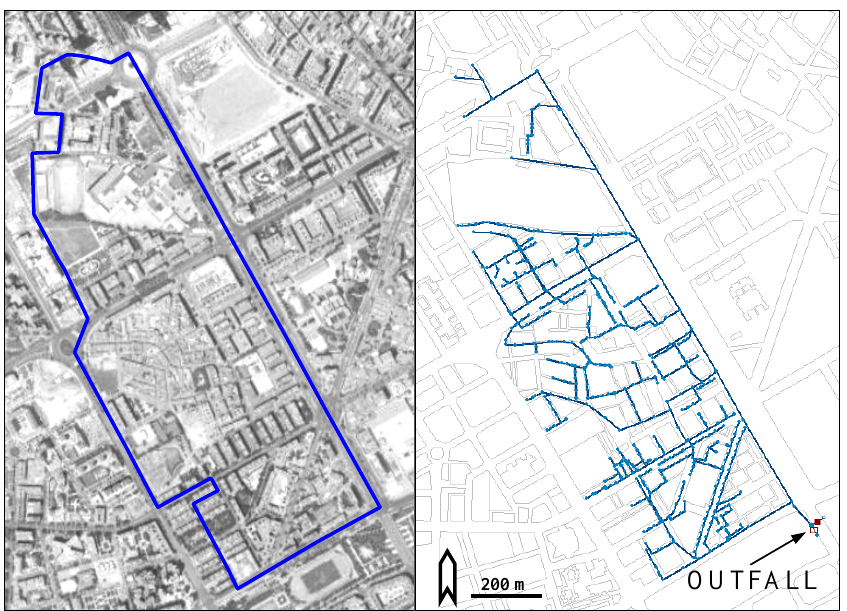
Fig. 2. The Pio XII urban catchment in Valencia: tributary area and